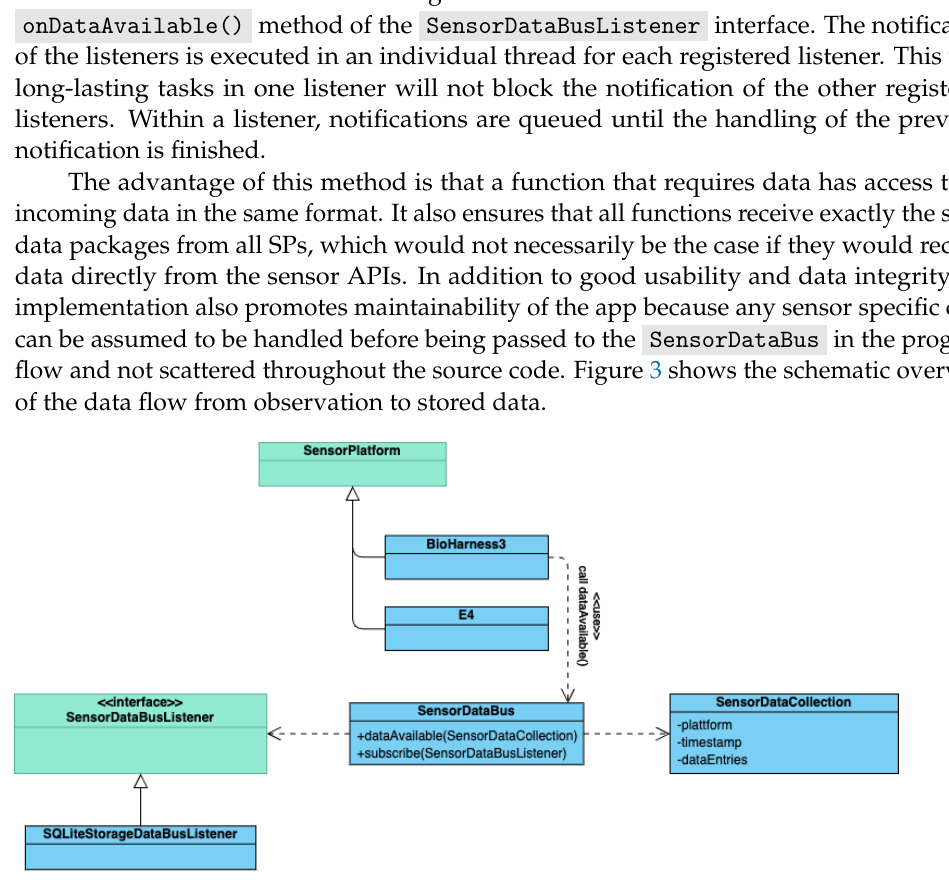
Figure 3. Schematic overview of eDiary data acquisition